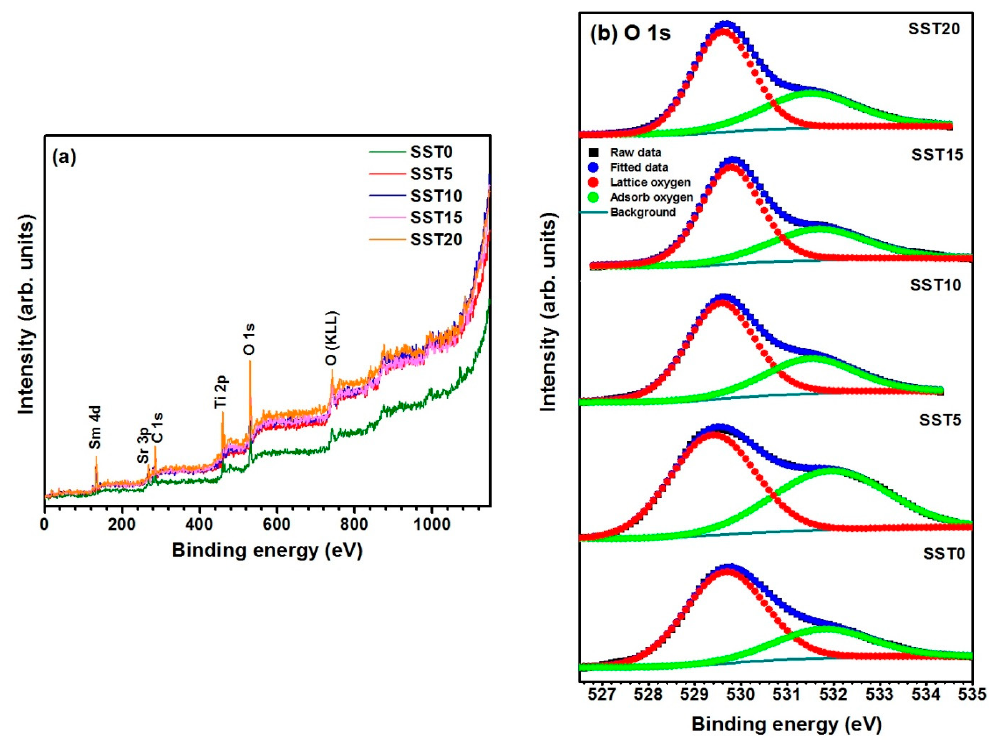
Figure 5. ( a ) The XPS wide spectra of Sm-substituted SrTiO 3 samples and ( b ) the illustration of the O 1s core level spectra of the samples.